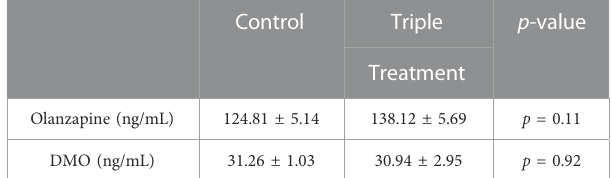
Sitagliptin = 9.31 ± 1.38, Olanzapine-Sitagliptin = 20.53 ± 8.64; Figure 2B), but not total (Mean ± SD: Vehicle-Control = 17.96 ± 8.81, Olanzapine-Control = 34.90 ± 10.37, Vehicle-Sitagliptin = 21.51 ± 16.27, Olanzapine-Sitagliptin = 24.04 ± 10.72; Figure 2C)